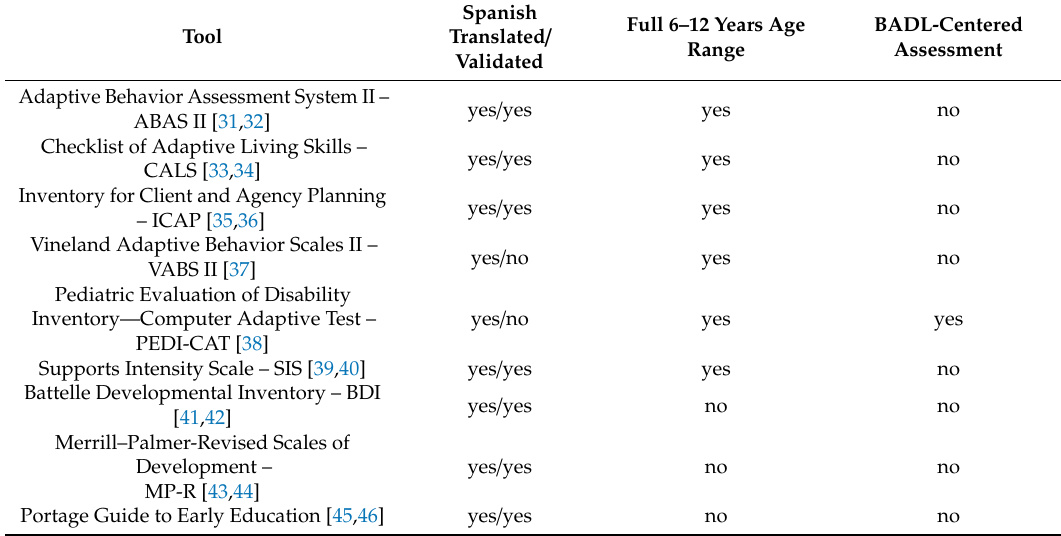
Table 2. Summary of BADL and adaptative behavior measurements for Spanish